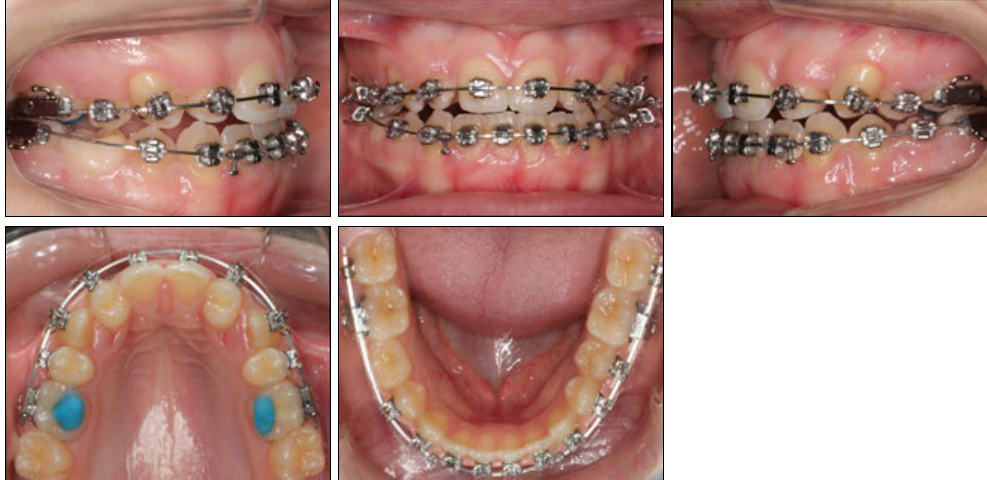
Figure 7. Treatment progress intraoral photographs showing uprighting springs.